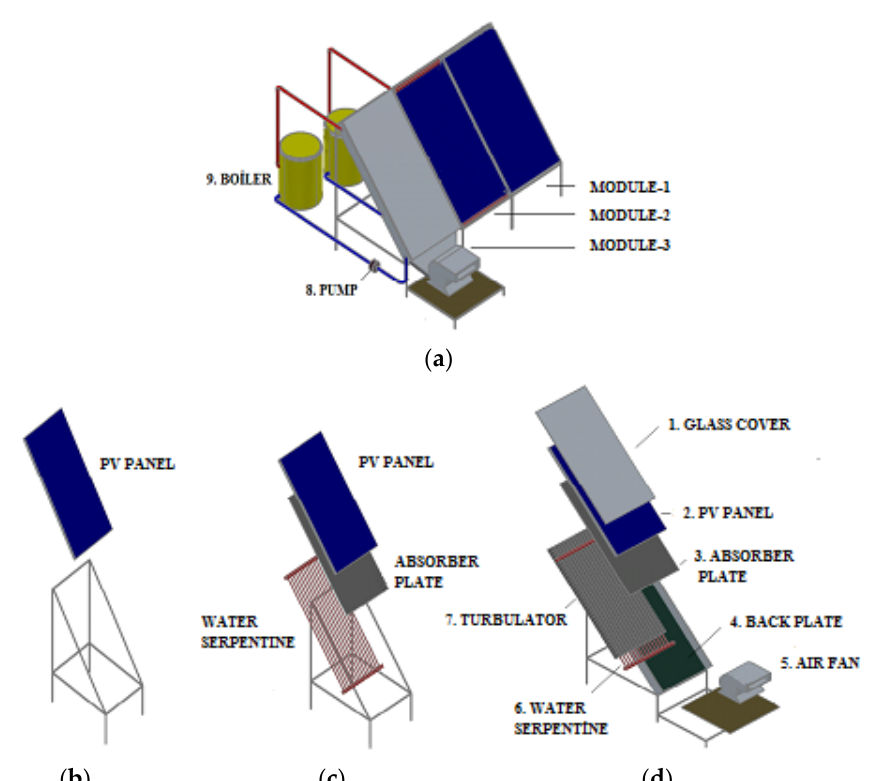
Figure 1. Description of the experimental set-up. ( a ) General shematic view of experimental set up.